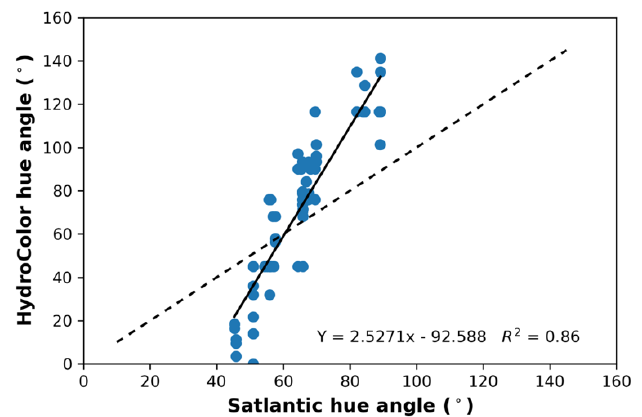
Figure 15. The hue angle of HC observations, plotted as a function of the Satlantic hue angle. The 1:1 reference line is shown, together with the steep linear trend line that fits the data. The solid line represents the regression through the data, and the dashed line represents the 1:1 relationship.